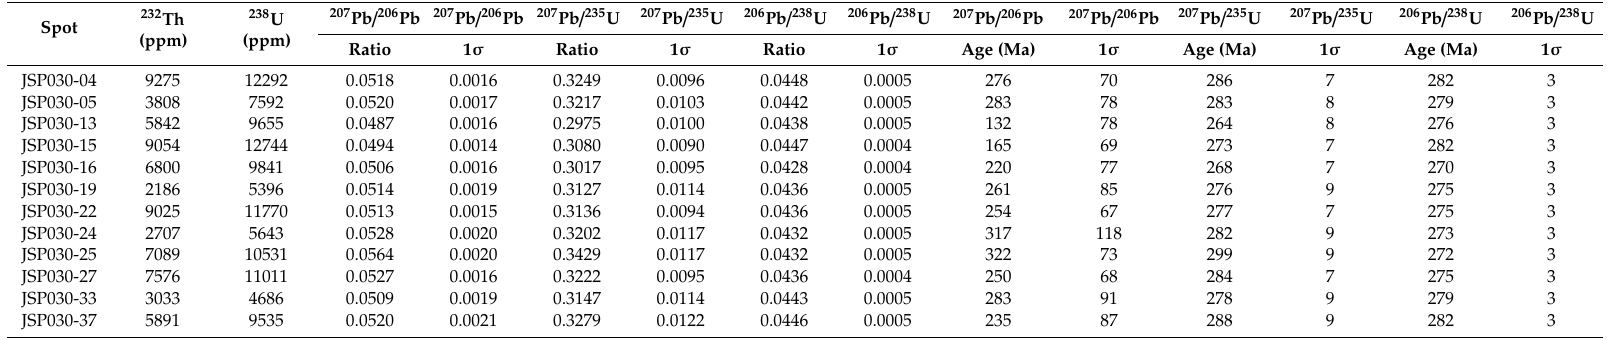
Table 2. LA-ICP-MS zircon U–Pb dating of biotite K-feldspar granite at the Jiashengpan